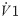
The four steps of the experiment are shown.A) Step 1, measurement of the endotracheal tube resistance before clamping; B) Step 2, inspiratory hold to detect air leaks in the entire set up; C) Step 3, endotracheal tube clamping, disconnection from the ventilator and measurement of airway pressure and flow over time; D) Step 4, measurement of the endotracheal tube resistance after clamping; Paw = airway pressure; t = time; V˙1 = flow measured with pneumotachograph number 1 (as in Fig 1); V˙2 = flow measured with pneumotachograph number 2 (as in Fig 1); Paw 1 = pressure measured with pressure transducer number 1 (as in Fig 1); Paw 2 = pressure measured with pressure transducer number 2 (as in Fig 1). Horizontal blue thin arrows indicate the inspiratory (I) and expiratory (E) direction. Black arrowed lines show the connection between the data logger and the Paw ports (broken lines) and flow meters (continuous lines).